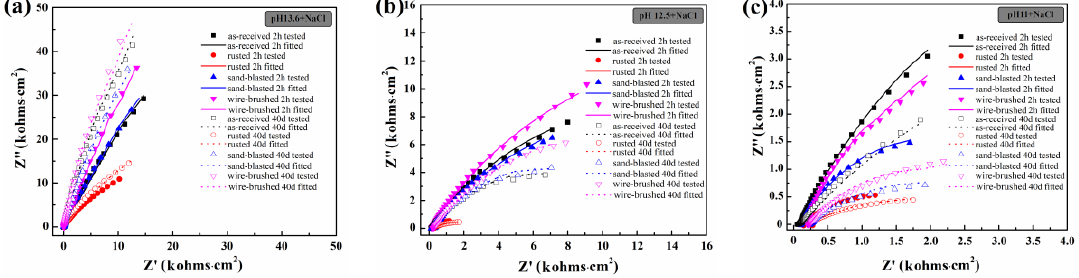
Figure 6. EIS Nyquist plots of the rebar in the Cl − -containing SCPS of di ff erent alkalinity: ( a ) pH 13.6, ( b ) pH 12.5, and ( c ) pH